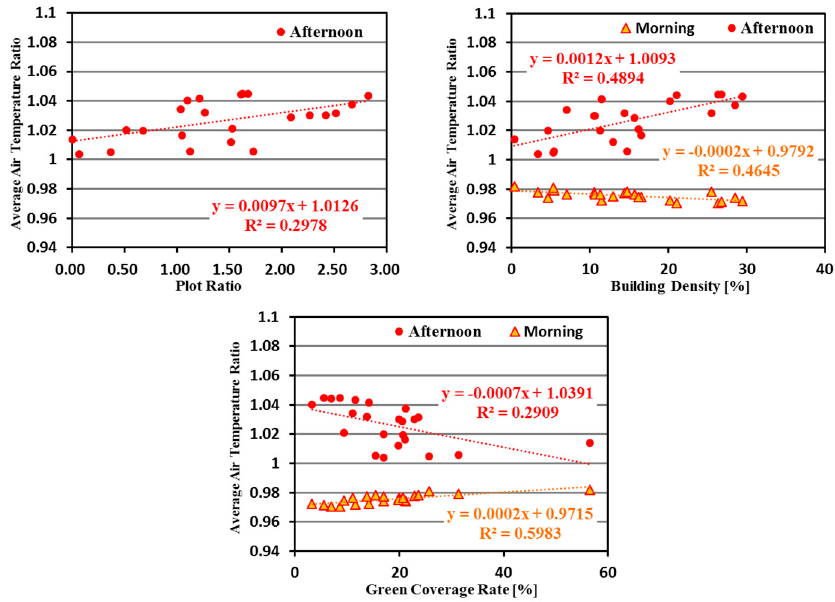
Figure 10. Relationships between urban morphology index ( x -axis) and air temperature ratio from the mobile and reference point ( y -axis) measurements in the residential district.